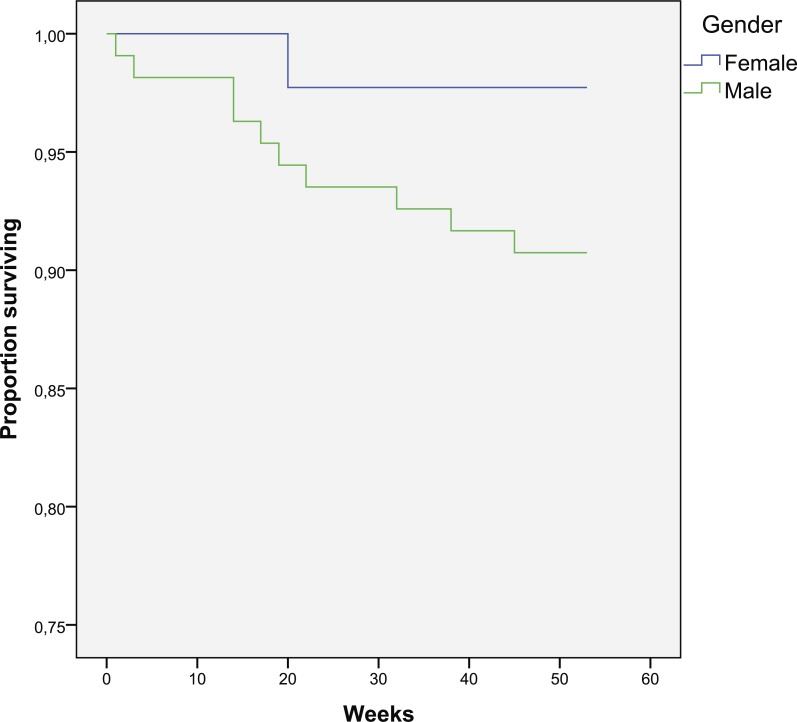
Kaplan–Meier curve for one-year survival depending on gender (in weeks).